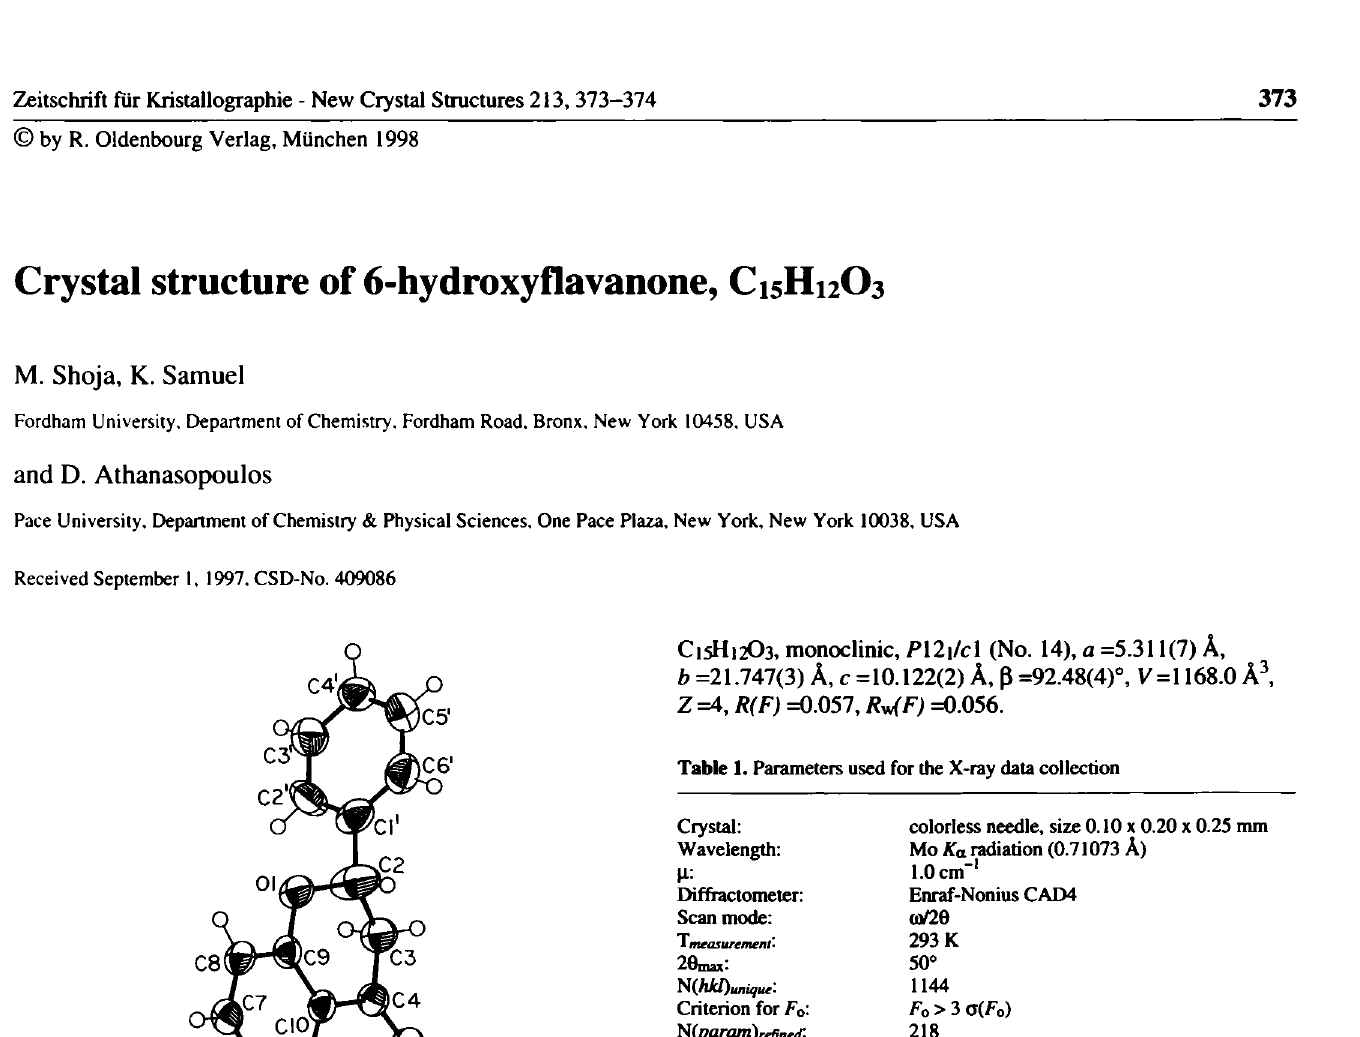
Table 2. Final atomic coordinates and displacement parameters (in